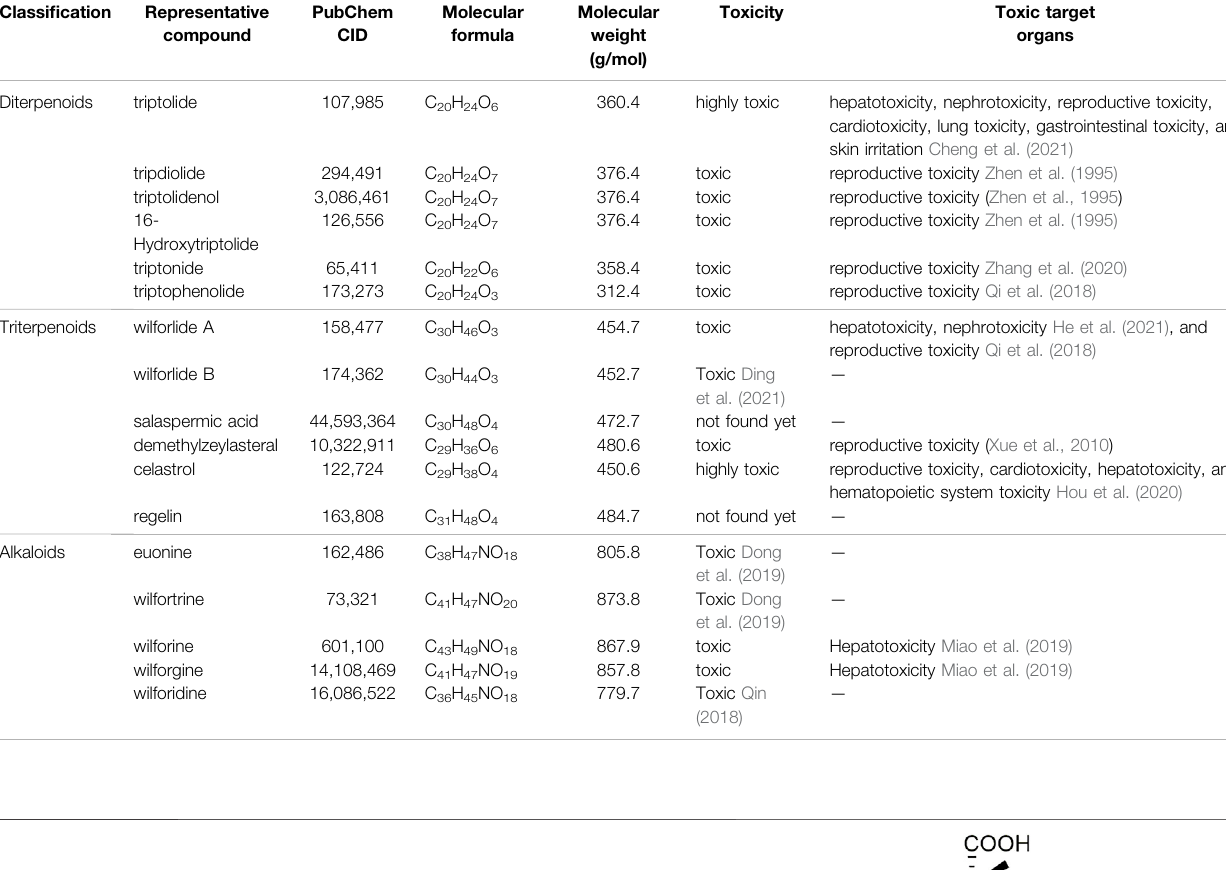
TABLE 1 | The most commonly studied natural active metabolites in TwHF.